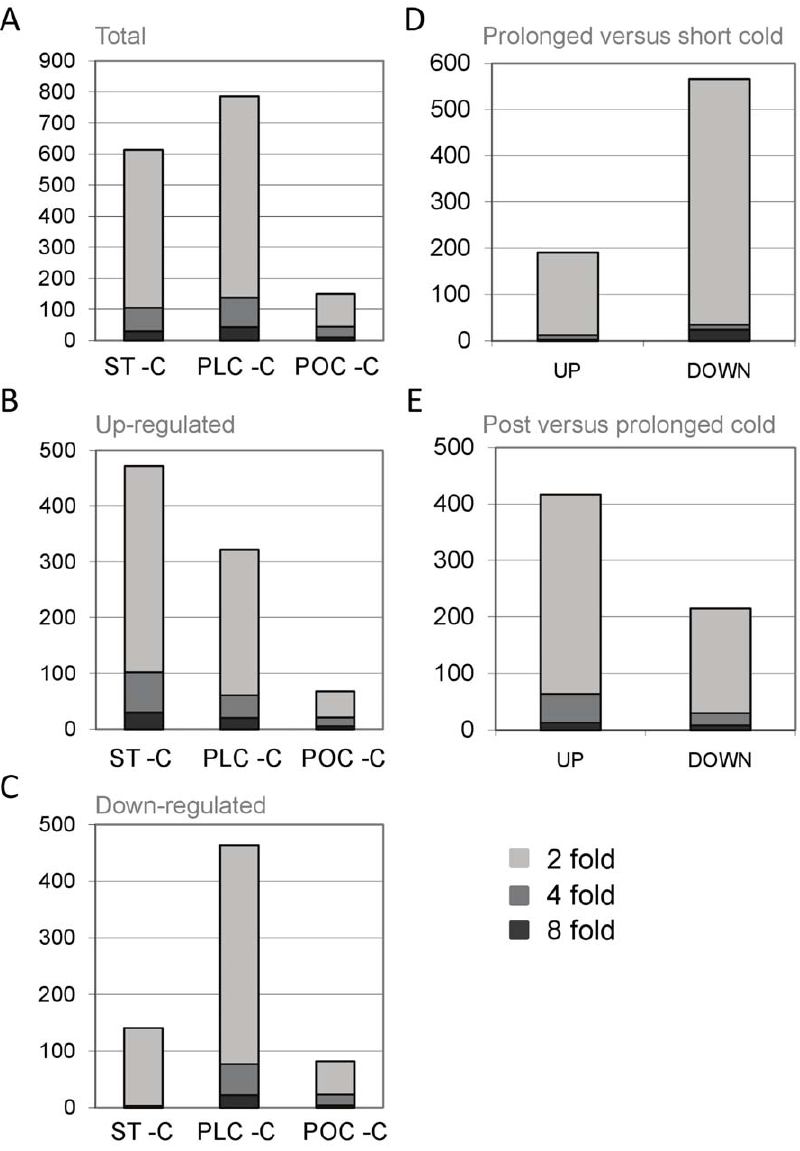
Figure 2. Changes in gene expression in seedlings after different low-temperature treatments. A) The total numbers of contigs showing differential expression ( . 2 fold change, p , 0.01) in the short term cold versus control (ST-C), the prolonged cold versus control (PLC-C) or the post cold versus control (POC-C) samples. B) The total numbers of genes up-regulated in the same comparisons. C) Genes down-regulated in the same comparisons. D) The total number of contigs up or down-regulated in the prolonged versus short term cold treatments. E) The number of contigs up or down-regulated in the post versus prolonged cold treatments. Dark shading indicates 8 fold change of greater, intermediate shading indicates 4–8 fold, light shading indicates 2–4 fold